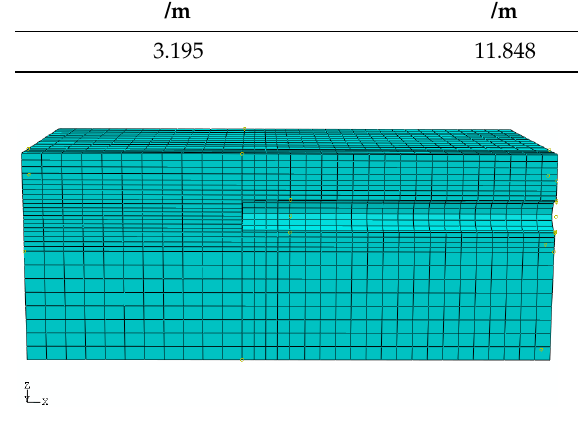
Table 8. Computing parameters of the tunnel.